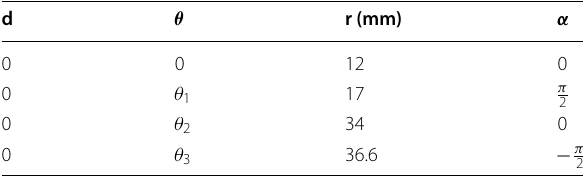
Table 1 Denavit–Hartemberg parameters of extra